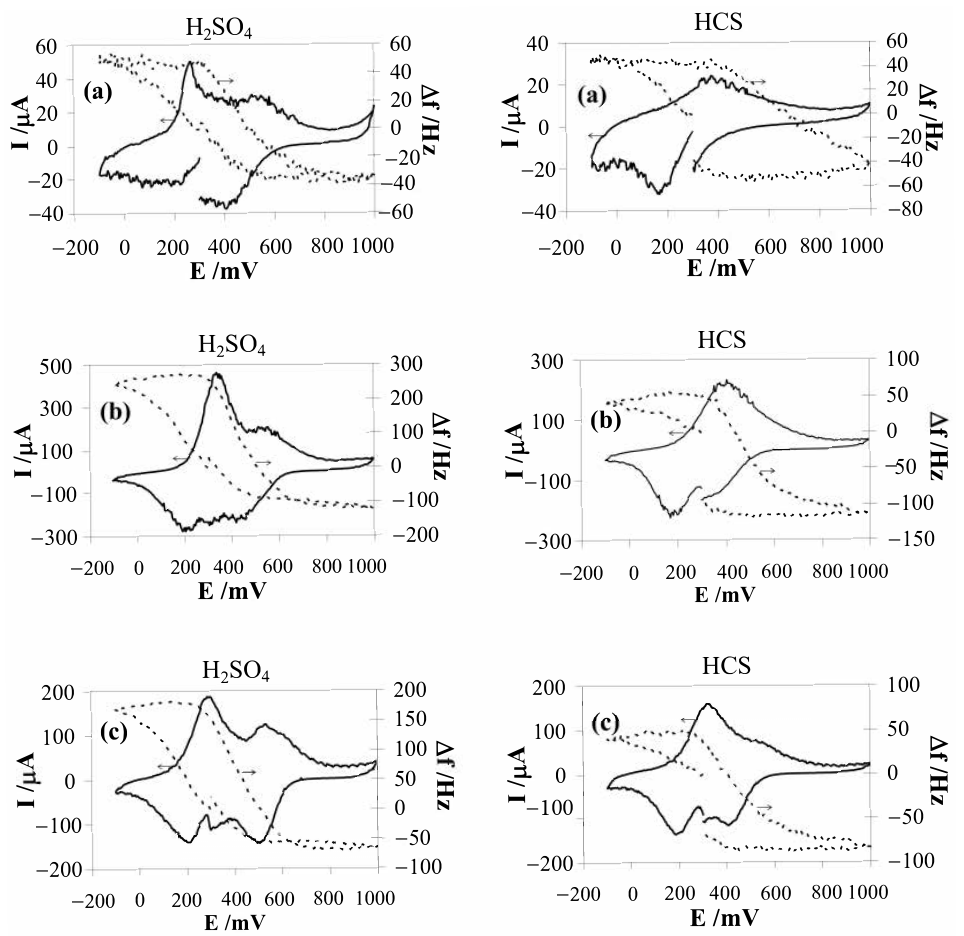
Figure 6. Voltammograms and frequency shifts concurrently recorded with CVs during the doping / dedoping process for PAni and PAni / PSS composites in 0.5 M H 2 SO 4 and HCS. In both type of curves, PSS concentrations of ( a ) 0, ( b ) 20 and ( c ) 40 mM were used. The scan rate was 50 mV /